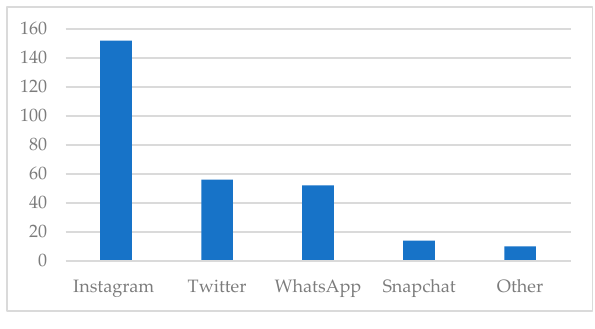
Figure 3. Top five traditional sources by platform.